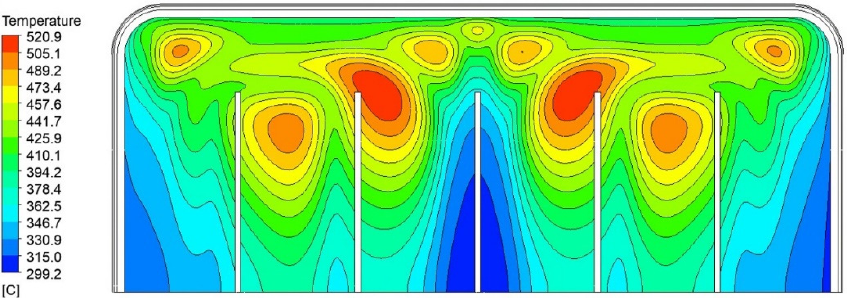
Figure 7. Temperature contour at the interface between the top radial–toroidal plate and PbLi do ‐ main.